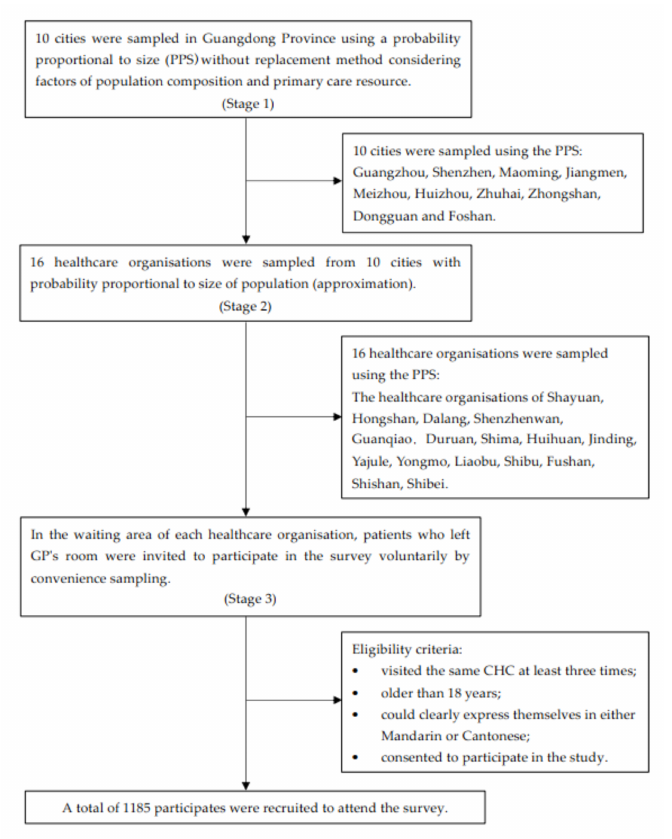
Figure A1. Flowchart of the study participant selection. A cross-sectional study using a three-stage cluster sampling was conducted from January to March 2019 in Guangdong,